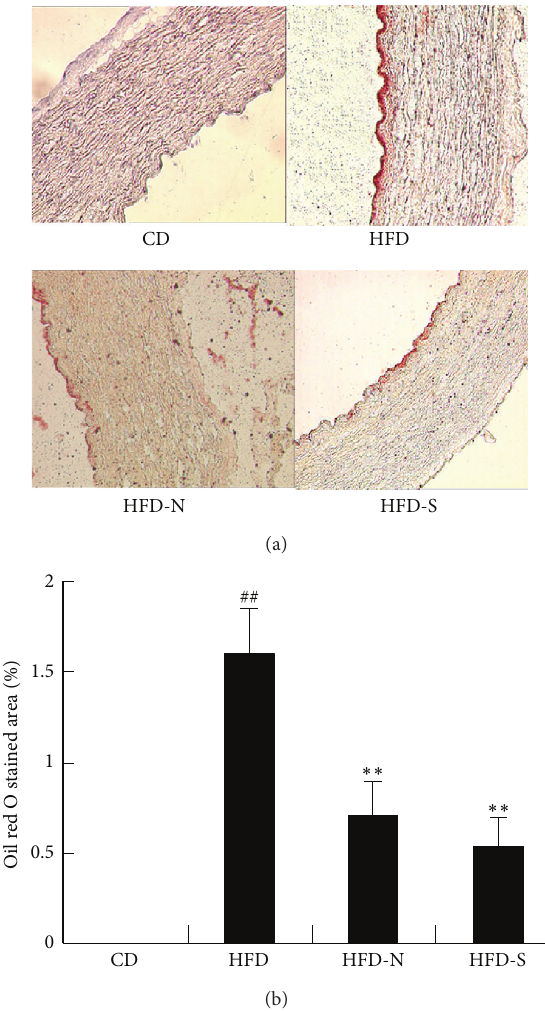
Figure 6: Niacin and simvastatin significantly lessened lipid depo- sition in the arterial wall of guinea pigs fed high fat diet. Lipid deposition in the aorta wall was analyzed by oil red O staining after treatment for 8 weeks. The quantification of stained lipids was deter- mined by calculating the percentage of the positive area to the total cross-sectional vessel wall area by Image-Pro Plus software. Data are presented as mean ± SD ( 𝑛 = 8 ). ## 𝑃 < 0.01 versus CD group; ∗∗ 𝑃 < 0.01 versus HFD